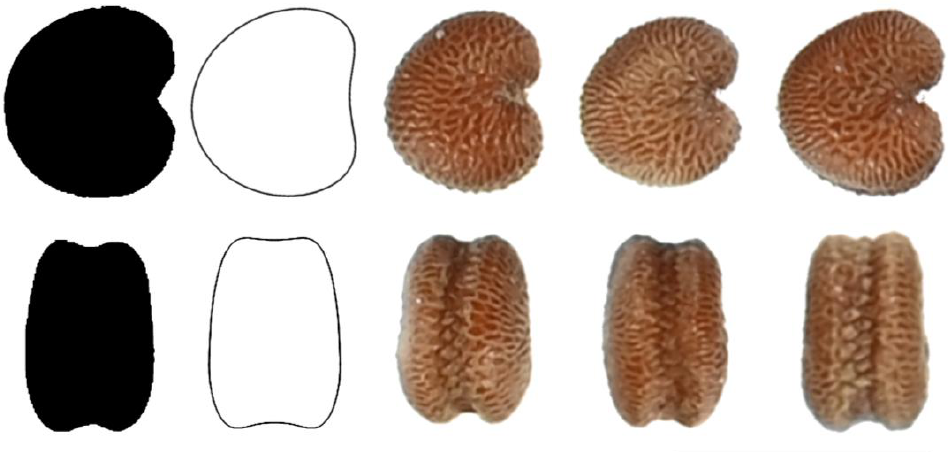
Figure 18. Silene villosa : average silhouettes (left), the models giving best scores with 20 seeds (LM8 and DM5), and three representative images for the lateral (above) and dorsal (below) seed views. Bar represents 1 mm.